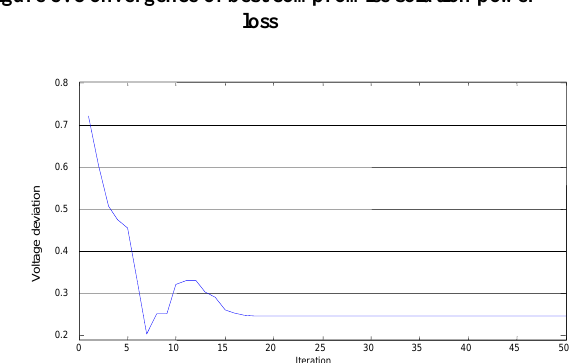
Figure 6. Convergence of best compromise solution